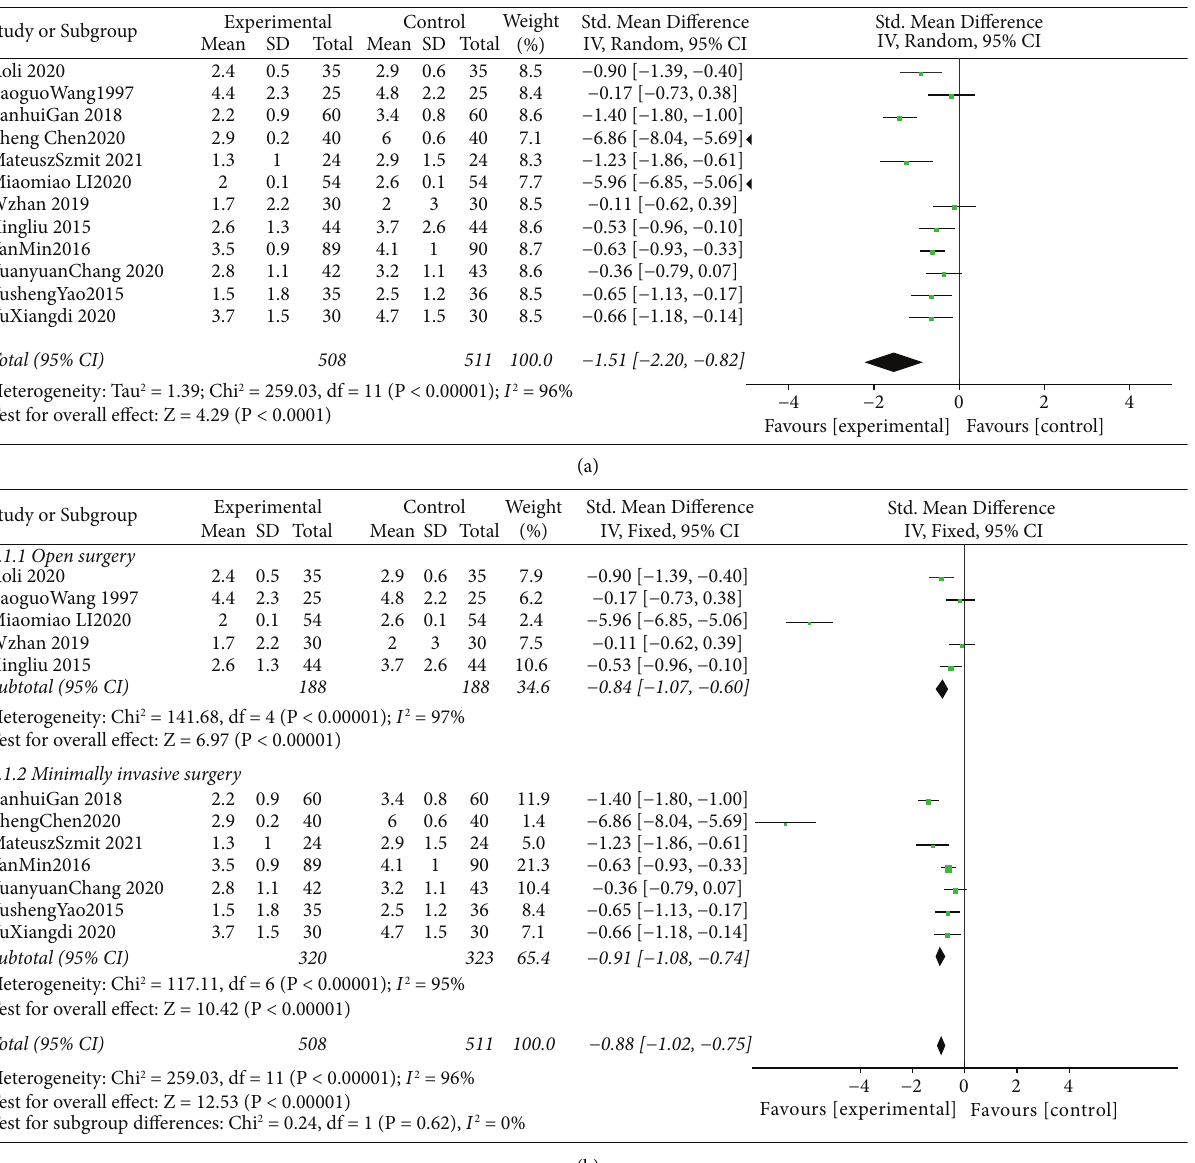
Figure 3: (a) Forest plots comparing the VAS at 24h between the TEAS and control groups; (b) subgroup analysis of the effect of TEAS for open surgery and minimally invasive surgery.